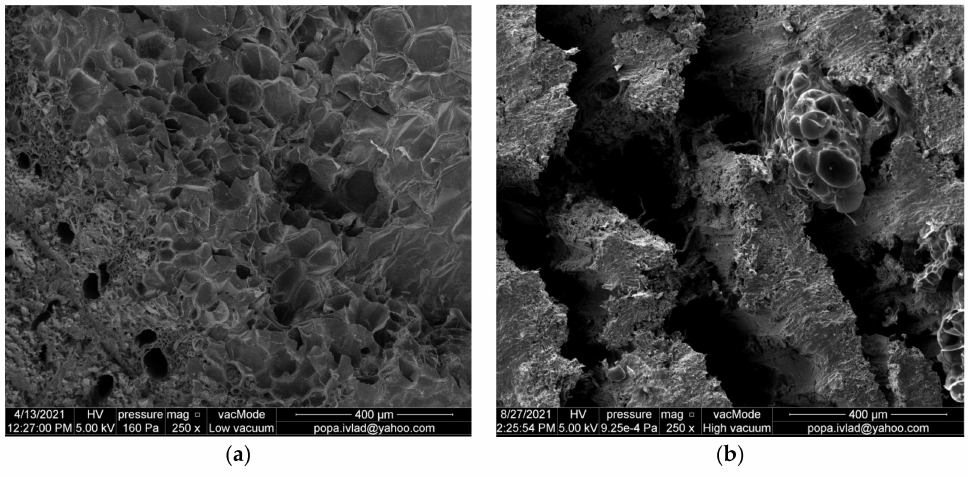
Figure 8. Scanning electron microscope (SEM) images of: ( a ) vine waste; ( b ) vine waste biochar. The FT-IR spectrum of vine waste biochar (Figure 9) shows four relevant peaks, i.e.,: (i) a first peak at 3199 cm − 1 ascribed to O–H stretching vibration of hydroxyl groups attached to aromatic rings [41,42]; (ii) a second peak at 1579 cm − 1 corresponding to C=C stretching in the aromatic ring [45]; (iii) a third peak at 1314 cm − 1 assigned to aromatic C–O stretching [45]; (iv) a last peak at 756 cm − 1 attributed to aromatic C–H bending vibrations (two adjacent H out-of-plane deformations) [41,44–46]. FT-IR spectrum suggests the presence of various aromatic hydrocarbons and some functional groups containing oxygen.